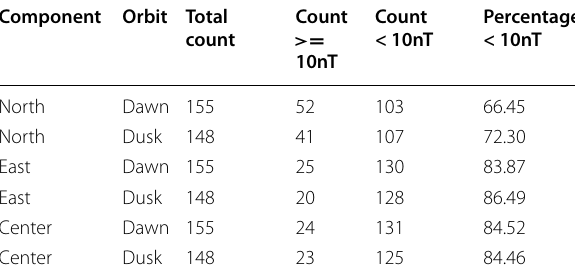
Table 3 Statistics of conjunction between the GOCE and CHAMP satellites corresponding to Fig. 11. The columns show different statistics for the dawn and dusk orbits for each NEC component for the residual between the satellites for distances within 1000 km, QDLAT <60 ◦ and split for below and above a residual of 10